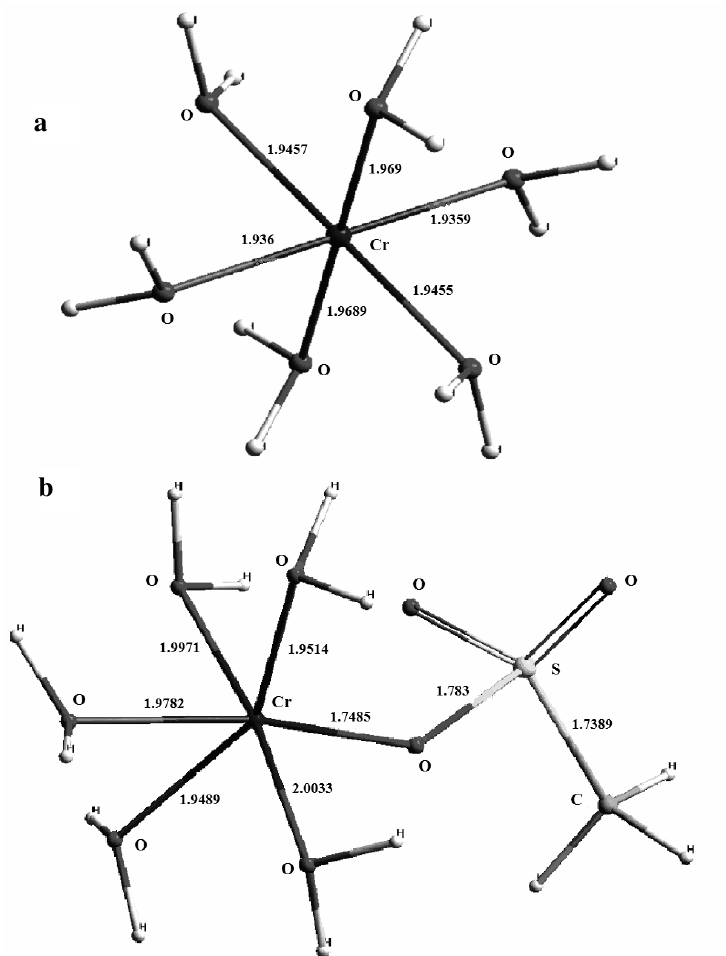
Figure 2. Equilibrium geometric structure of Cr(III) complexes (a) [Cr(H (b) [Cr(H